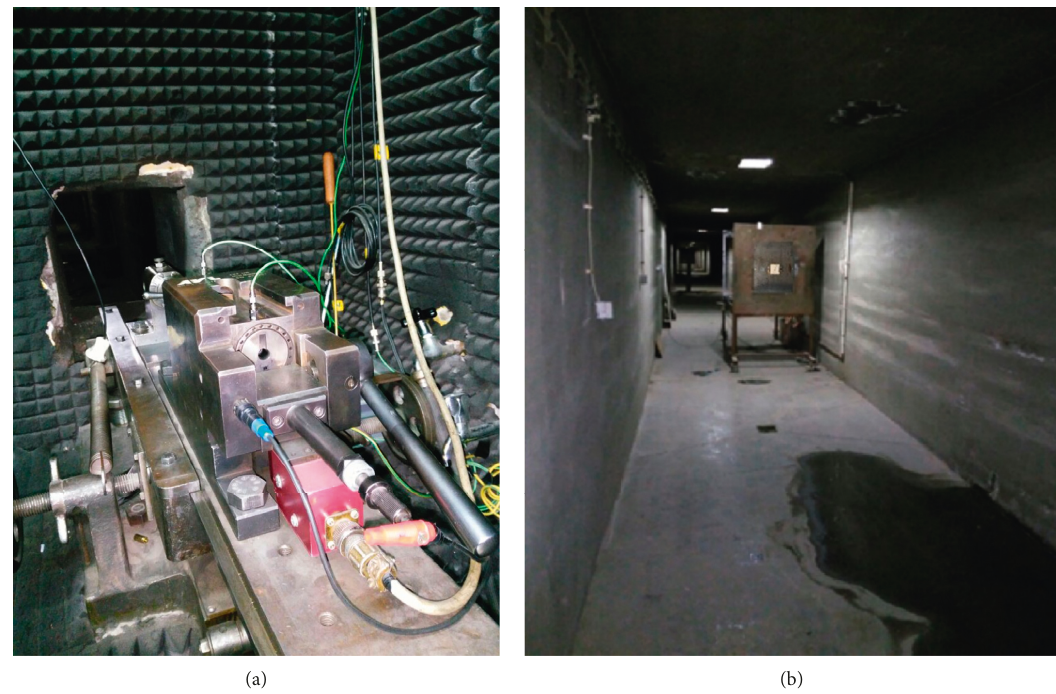
Figure 1: Images of test facility and ballistic testing mechanism.